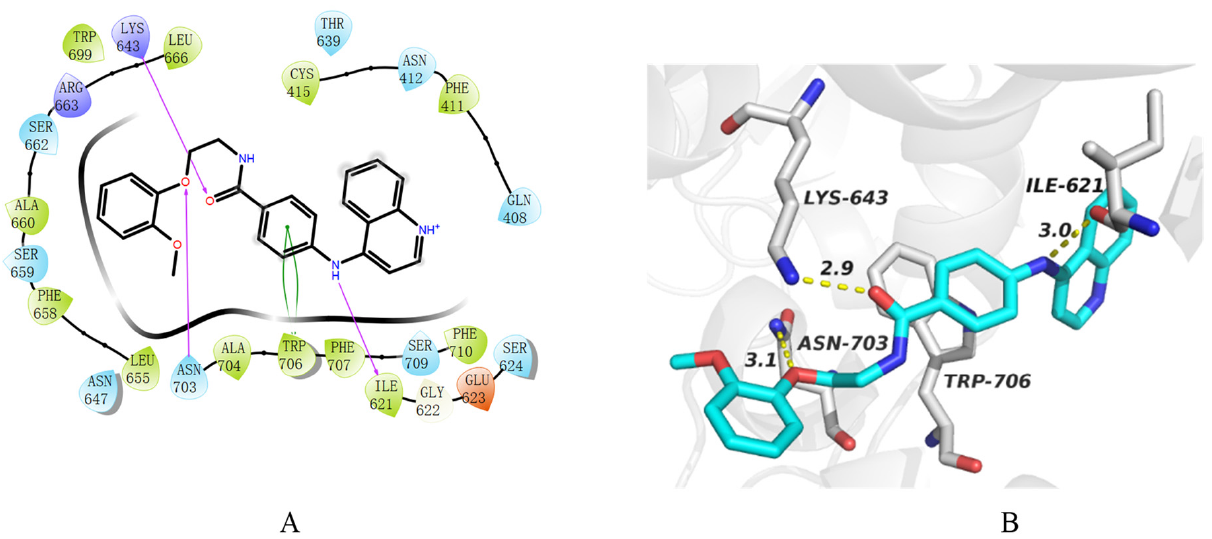
Figure 6. Docking model of G19 in the active site of RNA polymerase (PDB ID: 3CM8). ( A ) Two- dimensional (2D) diagrams of G19 -3CM8 interactions. The hydrogen-bond interactions with residues were represented by a purple dashed arrow directed towards the electron donor. The Pi-Pi stacking interactions with residues were represented by the green line segment. ( B ) Three-dimensional (3D) diagrams of G19 -3CM8 interactions. The hydrogen-bond interactions with residues were represented by a yellow dashed line.